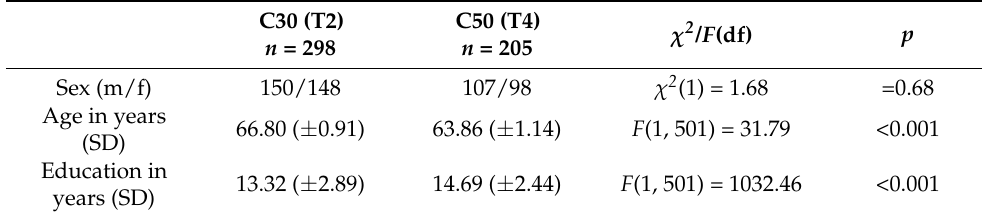
Table 1. Demographic characteristics of the